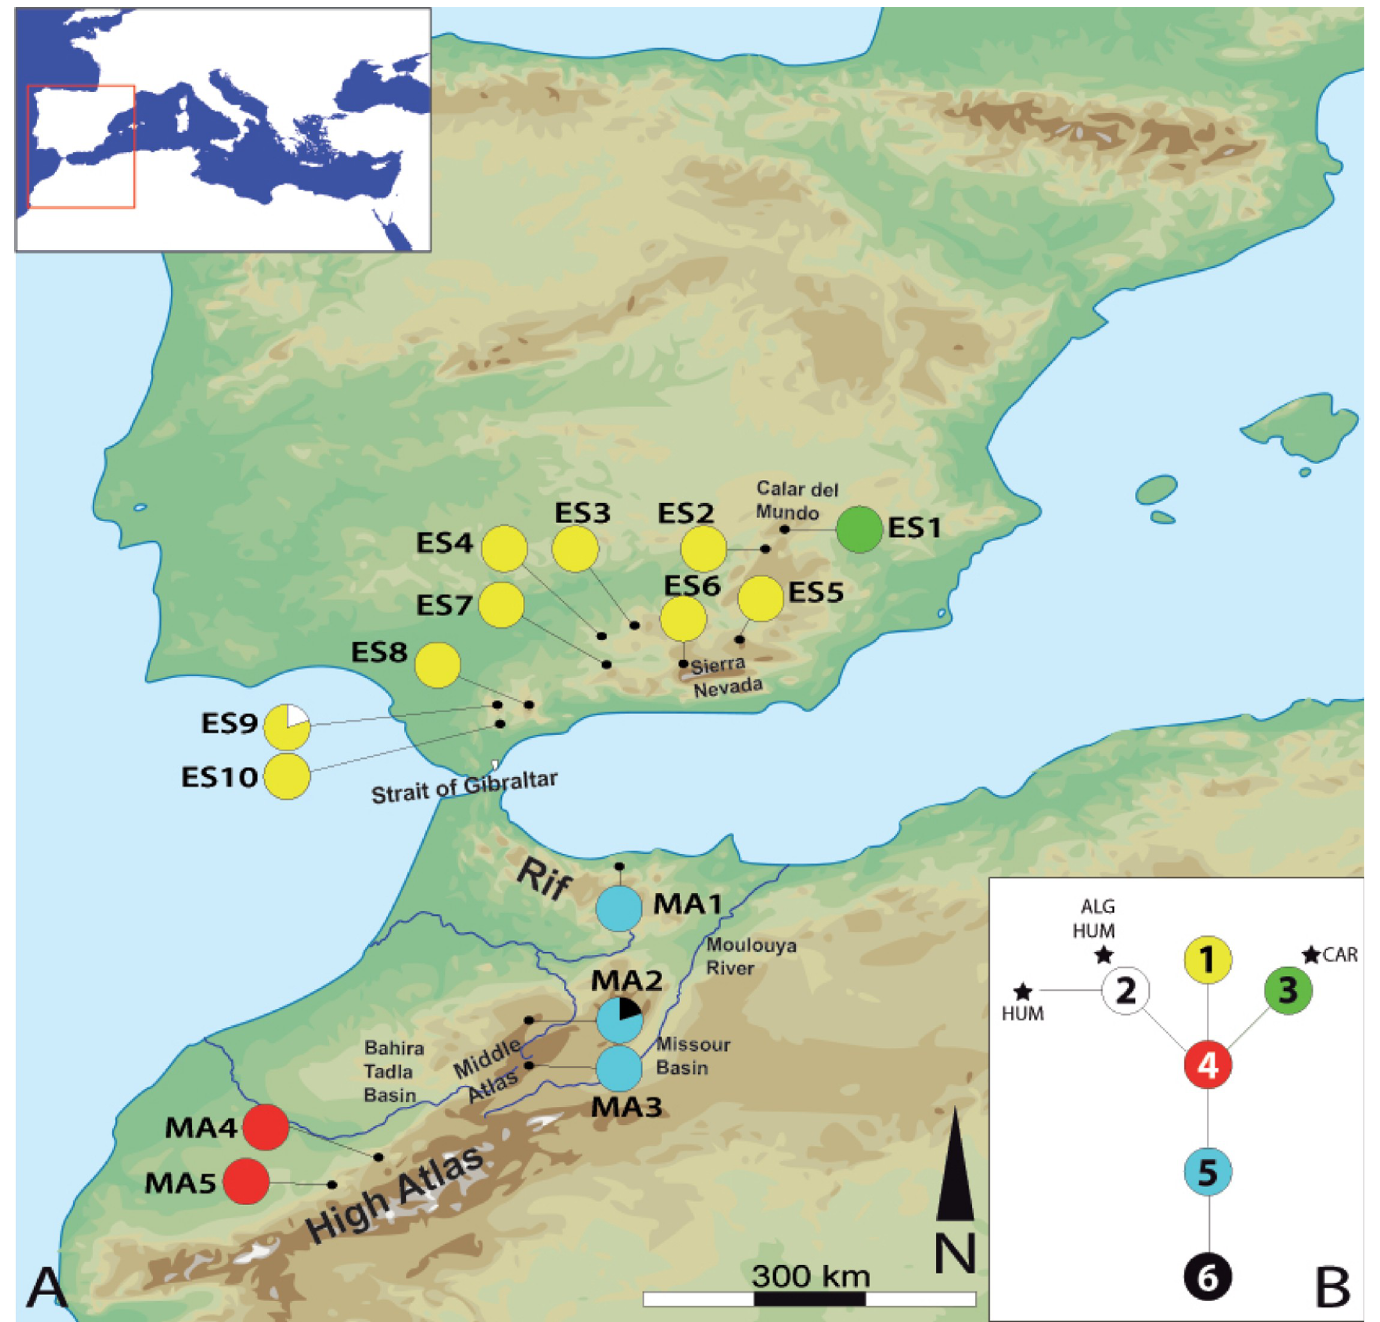
Fig 1. Location and haplotypes of the studied Cynara baetica populations. (A) Location and haplotype distribution of the 15 studied populations of Cynara baetica . (B) Statistical parsimony network of C . baetica haplotypes (indicated by numbers). Stars indicate three outgroups (ALG = C . algarbiensis ; CAR = C . cardunculus ; HUM = C . humilis ). All the geographical features referred to in the text are also